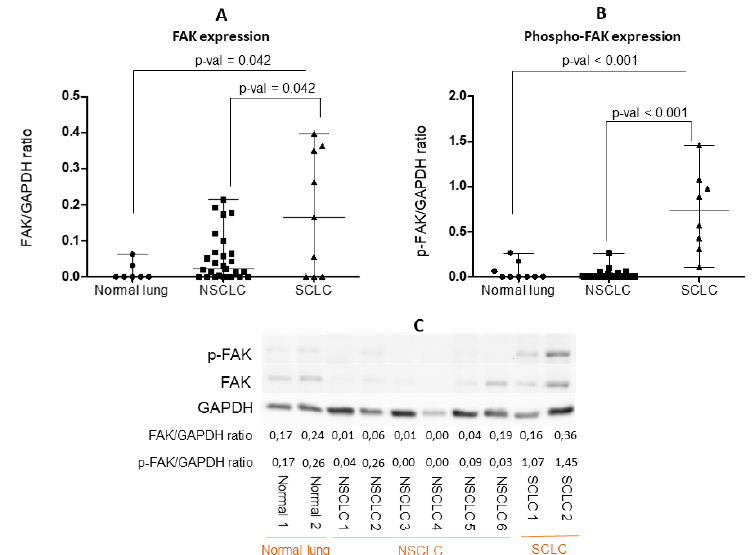
Figure 5. Quantification of ( A ) FAK and ( B ) phospho-FAK expression evaluated by Western blot (WB), with normalization to glyceraldehyde 3-phosphate dehydrogenase (GAPDH ) expression, in nine normal lungs, 30 non-small-cell lung cancer (NSCLC), and 10 small-cell lung cancer (SCLC) tissue lysates. Each dot represents one sample. Data presented as the mean ± S.D. Significance determined by the Kruskal-Wallis test. ( C ) Illustration of a representative WB of FAK and phospho-FAK (Y397) expression in normal lung, NSCLC, and SCLC tissue lysates. All the WB are represented in Supplementary Figure